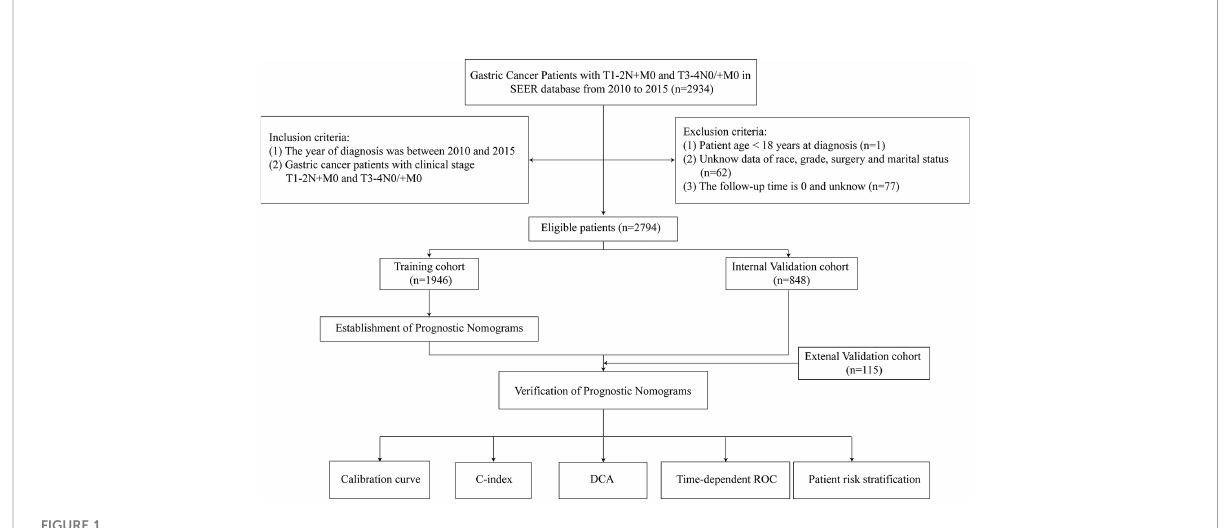
FIGURE 1 Flowchart of participant inclusion and